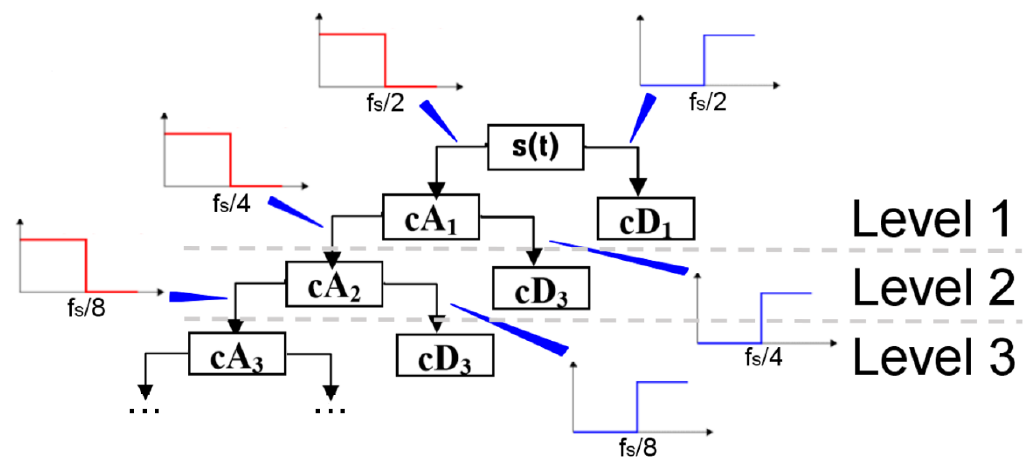
Figure 1. Wavelet decomposition process of s(t) signal on subsequent levels of decomposition.